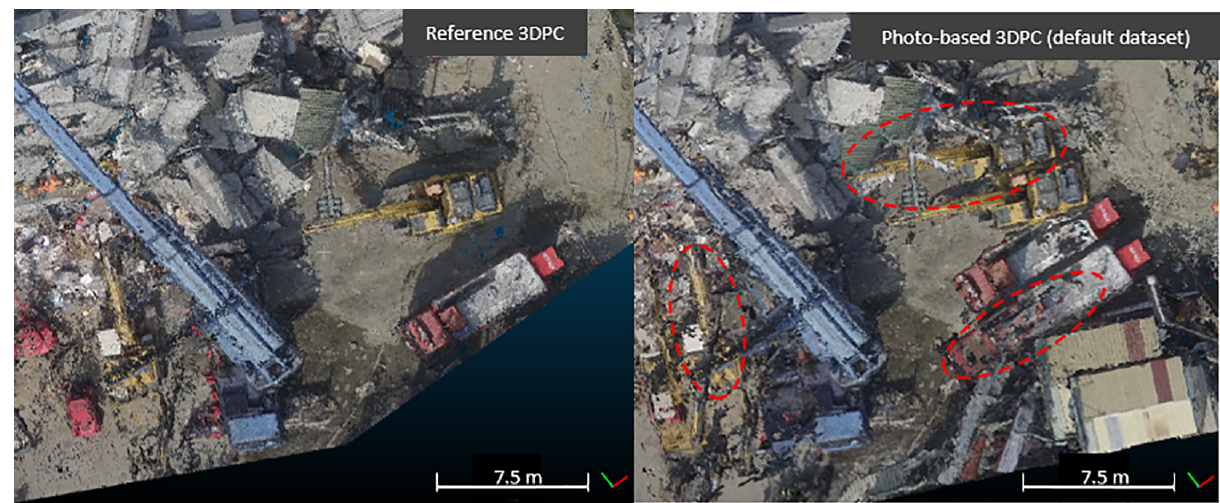
Figure 13. Displacement effect in 3DPC generated with the default photo dataset (combined nadir and oblique photos), due to a misregistra- tion or differences in spectral and spatial characteristics between oblique and nadir datasets. Red dashed circles: noise in